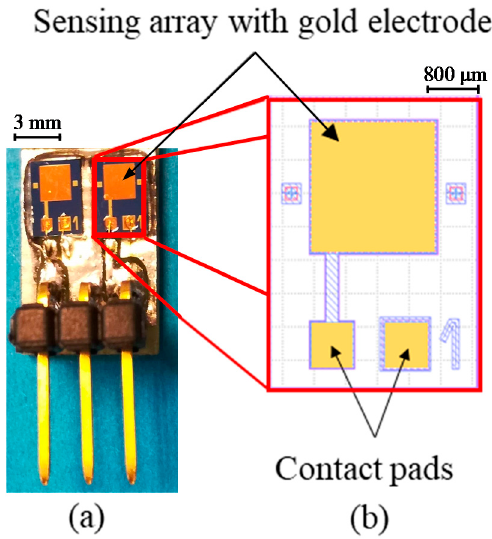
Figure 3. ( a ) Two CMUT chips assembled on a custom printed circuit board with connection pins and contact pads bonded to the printed circuit board (PCB) with gold wires, ( b ) design of the CMUT